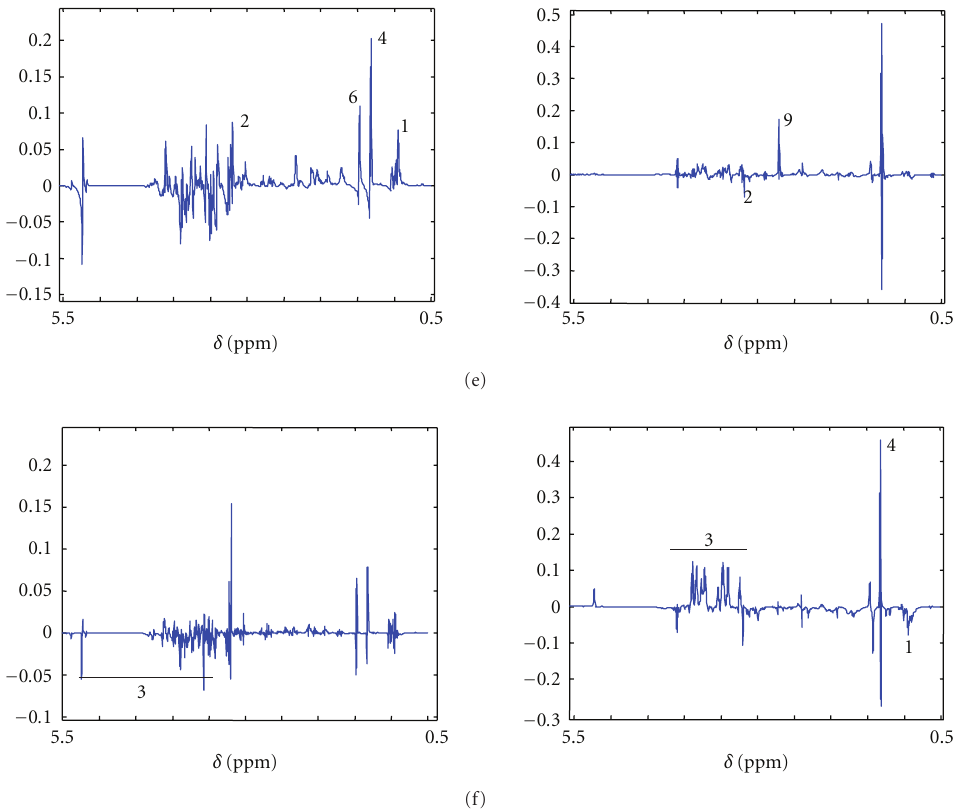
Figure 4: The liver and serum correlation profile depicted by MPCA PC2 loadings plot. The aliphatic region of the spectra is shown.(a–c) are females and (d–f) are the males. In each set, the left figure is the liver profile and the right one is the serum profile. The y -axis in each panel represents the loading axis. The compartmental loadings are obtained by cropping the model loading. (a/d): control, (b/e): early infection, and (c/f): late infection. Symbols: 1: branched chain amino acids, 2: choline, 3: glucose, 4: lactate, 5: lysine, 6: alanine, 7: trimethylamine oxide (TMAO), 8: glycine, 9: dimethylamine, and u: unidentified